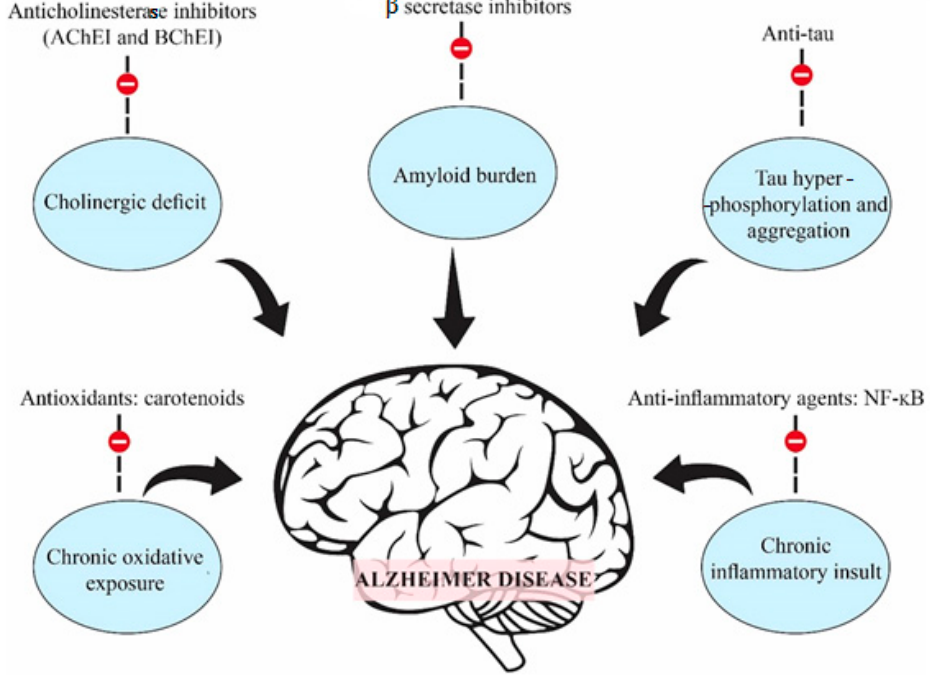
Figure 1. Schematic diagram showing five of the most important therapeutic targets in Alzheimer’s disease. Reprinted with permission from Ref. [2]. Copyright 2021